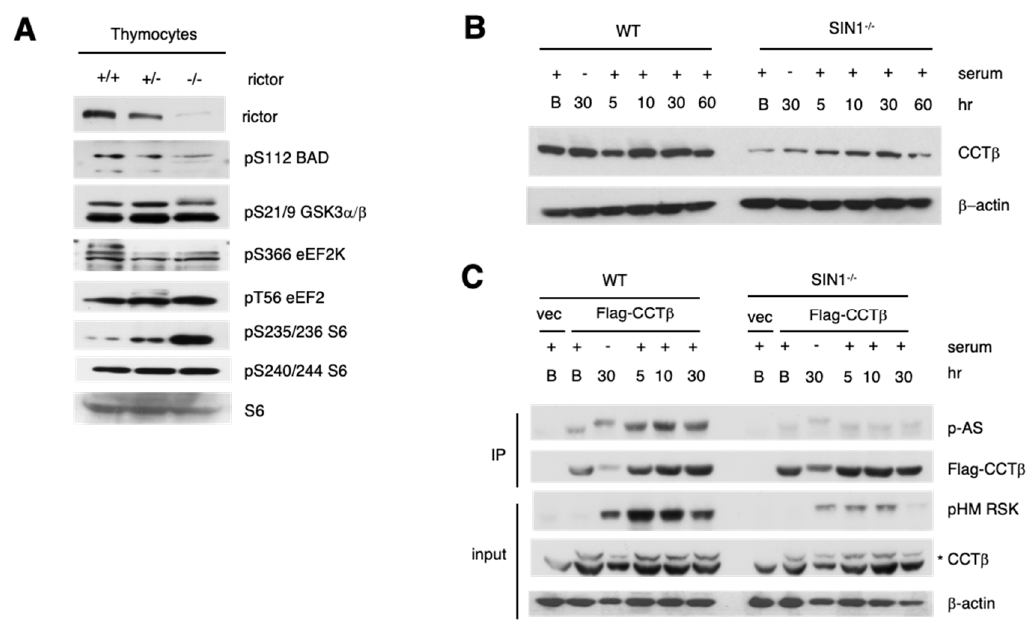
Figure 7. The RSK substrate CCT β has defective phosphorylation and expression in the absence of mTORC2. ( A ) Thymocyte lysates from wild type (rictor +/+ ), rictor +/ − , or rictor − / − littermates were resolved by SDS-PAGE and analyzed for phosphorylation of known RSK substrates by immunoblotting. ( B ) Wild type (WT) or SIN1 − / − MEFs were grown in complete DMEM (Basal; B) or grown then serum-starved overnight. Cells were then left starved (–) or serum was re-added and cells were incubated for the indicated times. ( C ) WT or SIN1 − / − MEFs were transfected with Flag-CCT β plasmid or vector control (vec). Cells were starved and re-stimulated with serum as in B . Lysates were subjected to immunoprecipitation using Flag antibody. Immunoprecipitates were fractionated and blotted for CCT β phosphorylation (using the Phospho-Akt consensus motif substrate antibody (P-AS)) or Flag. Total extracts (input) were also fractionated by SDS-PAGE and immunoblotted for pHM RSK or CCT β . ( * ) indicates exogenous Flag-CCT β , lower band is endogenous CCT β .